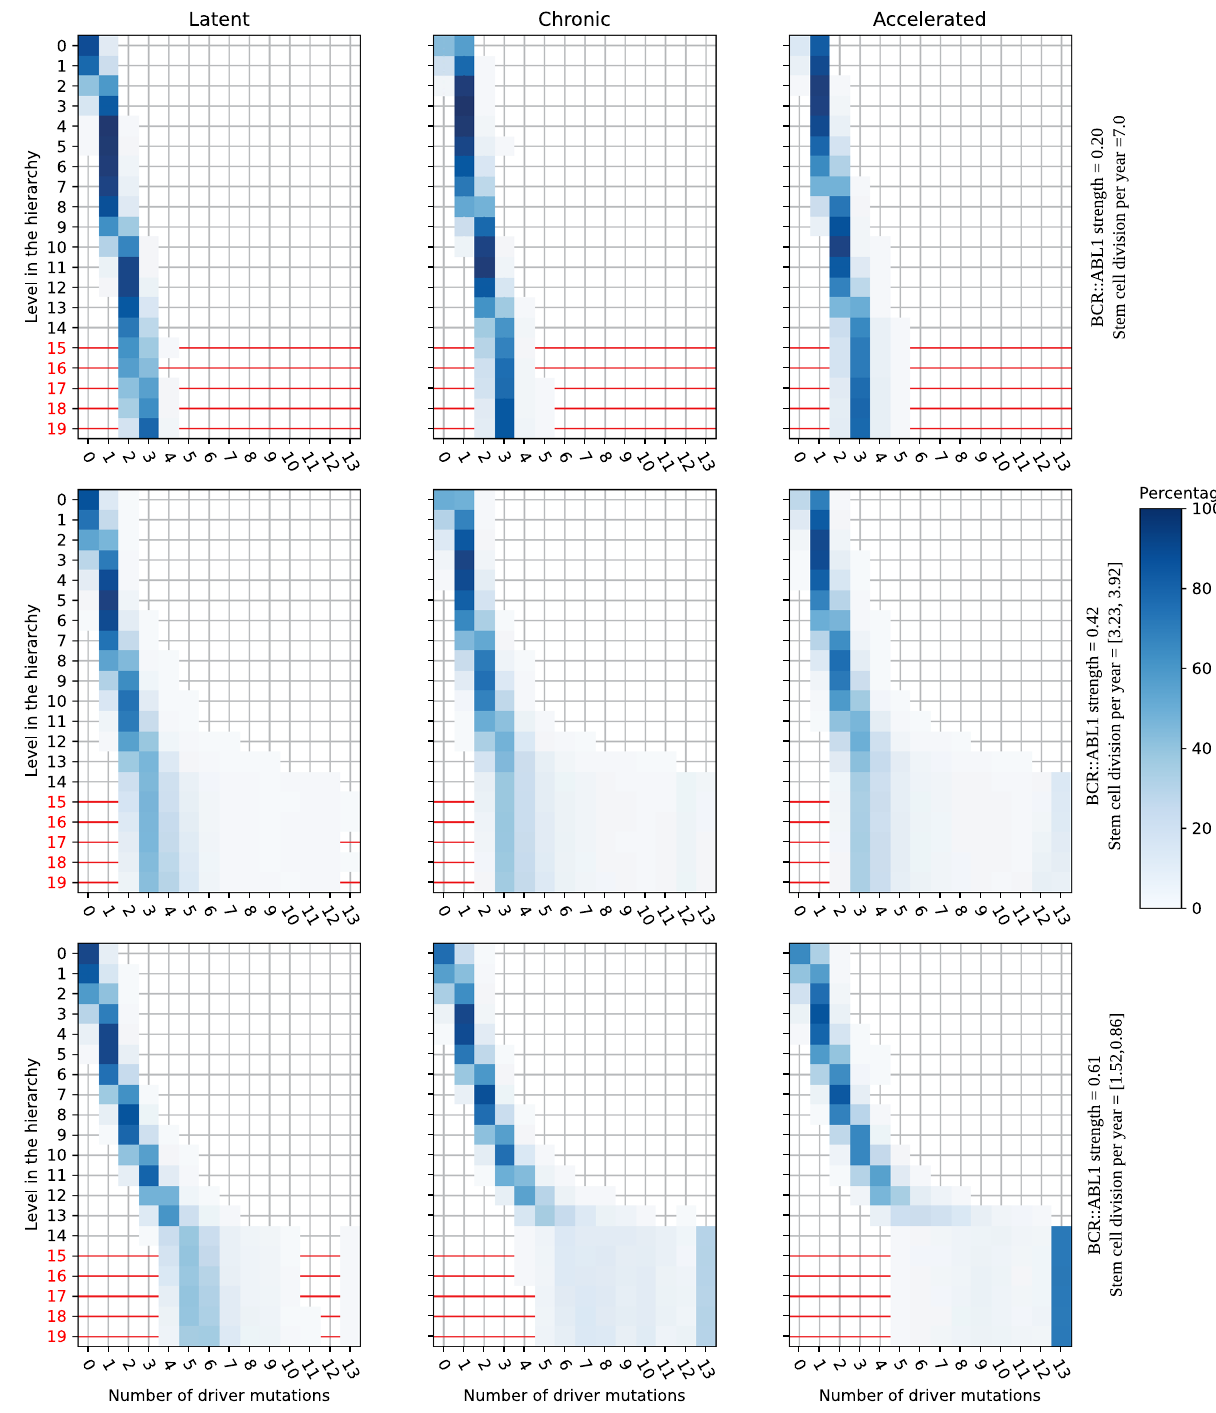
Figure 6. Distributions of the maximum number of generic driver mutations carried by a cell at each level of the hierarchy at the end of the three progression phases. Each row shows the mutational distribution of the hierarchy at the end of the latent, chronic, and accelerated phases for a specific value of the BCR::ABL1 mutation strength. For each individual panel, every horizontal line displays a histogram of the maximum number of additional generic driver mutations in a cell at a given level. The color of each square with center coordinates ( x , y ) indicates the percentage of simulations in which x is the maximum number of driver mutations carried by a cell at level y in the hierarchy. To distinguish between mitotic pools I and II, we show the level labels of the latter in red. Cells at every level of the hierarchy develop more driver mutations with